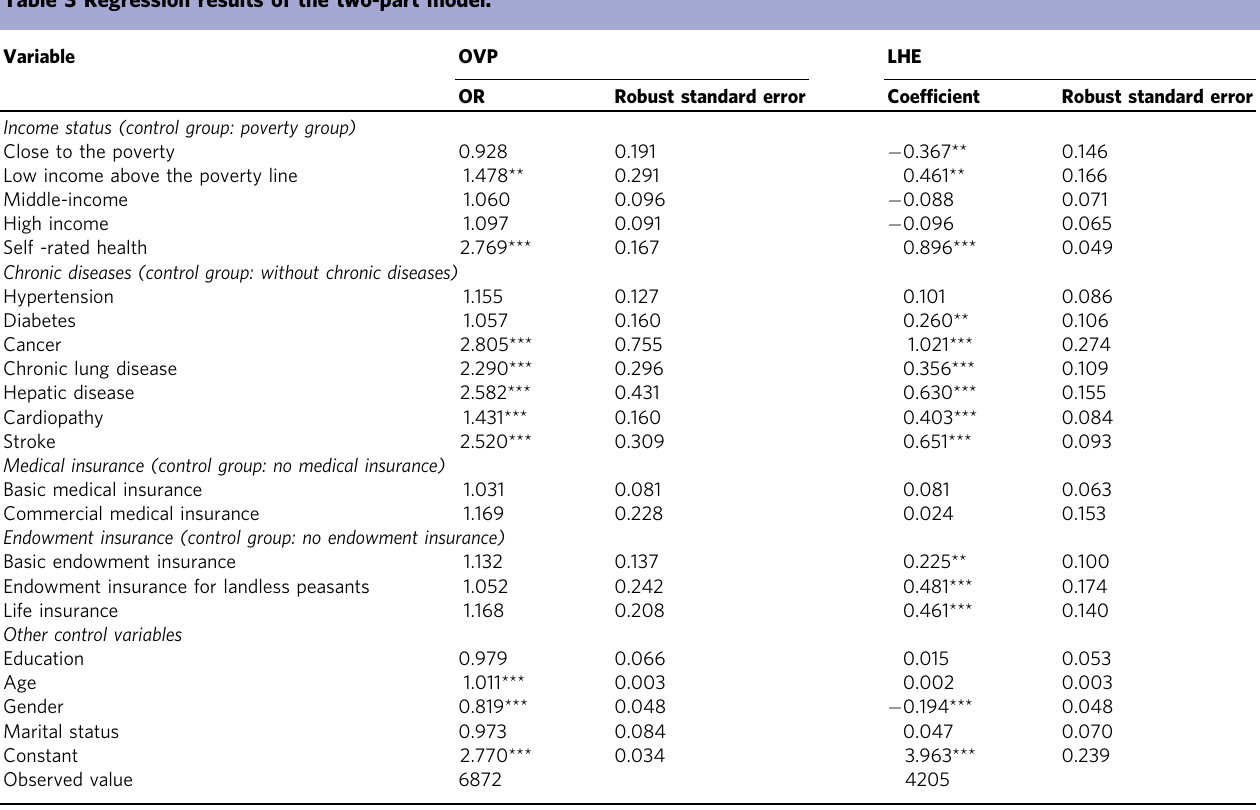
Table 3 Regression results of the two-part